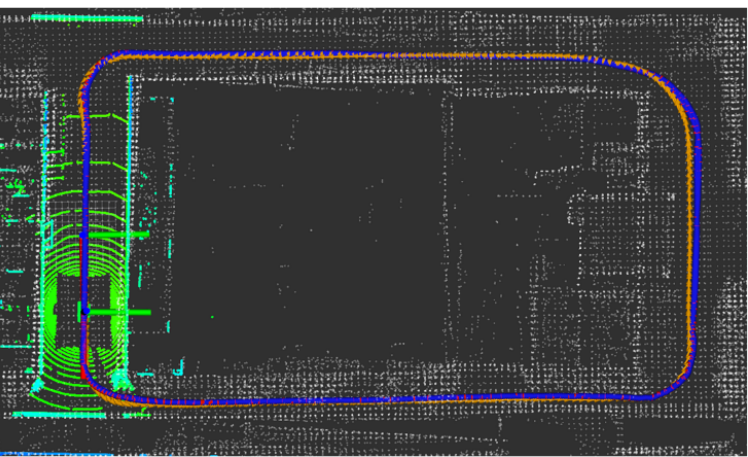
Figure 26. Field test NO.3. Two laps under normal driving scenario localization test in prior point cloud map. The white points in the figure are the point cloud map built by the offline mapping process, the red line is the trajectory of LiDAR matching results, the orange line is groundtruth, and the blue line is the fused trajectory.